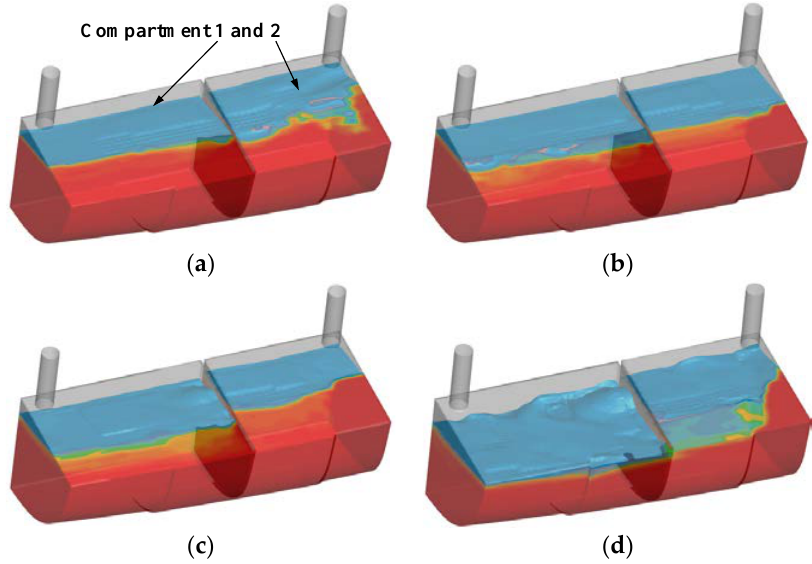
Figure 19. Comparison of water surface in compartments for the ship under asymmetric flooding at